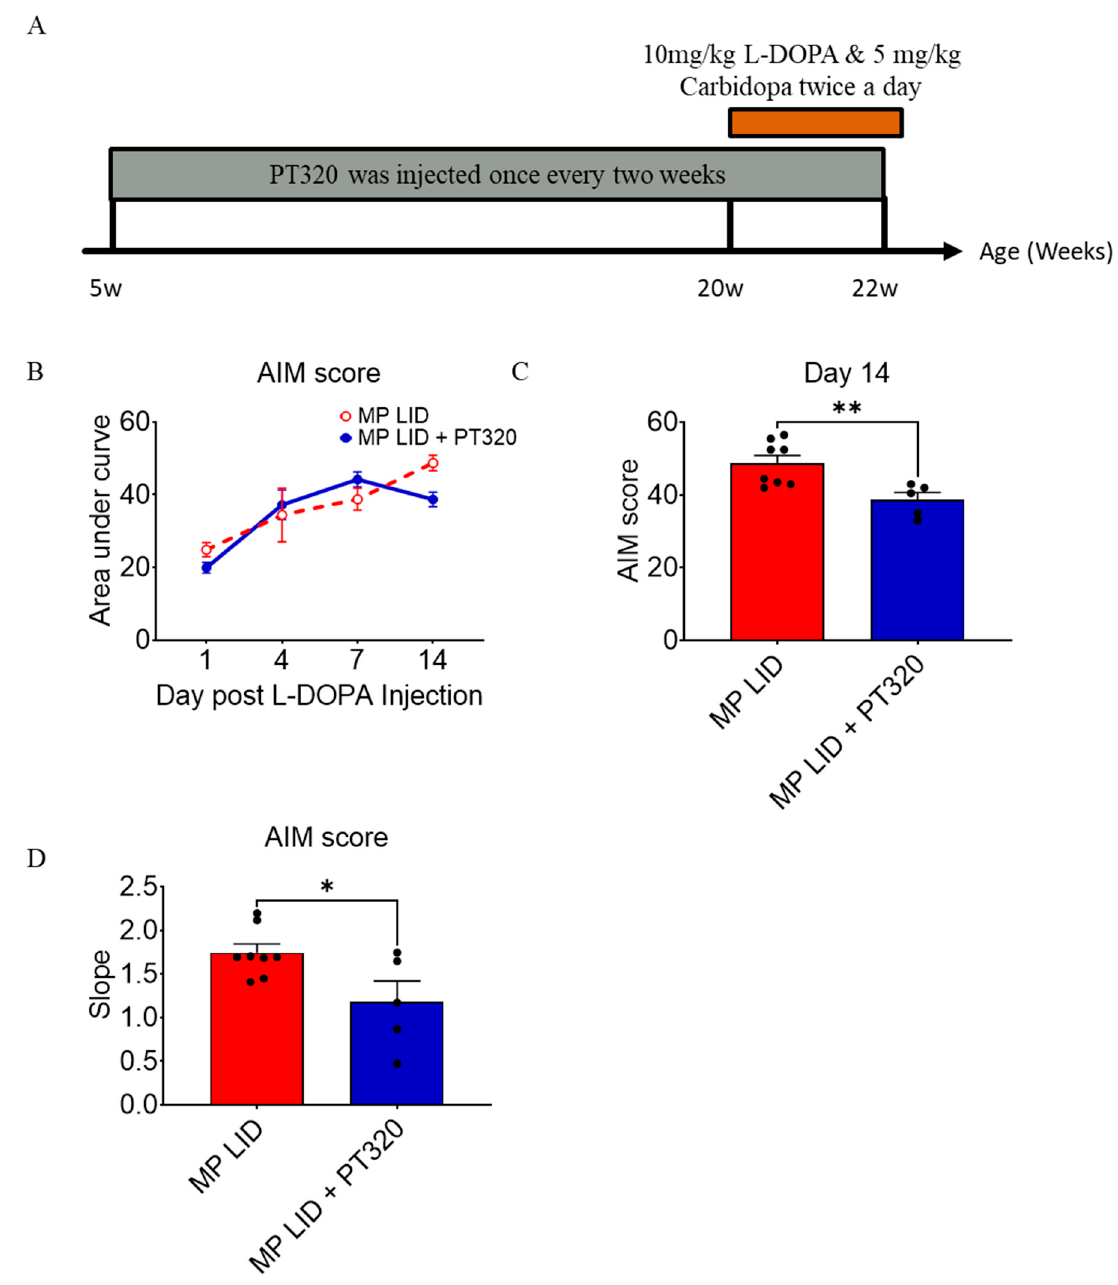
Figure 2. The early administration of PT320 ameliorated the severity of dyskinesia induced by L-DOPA injection after a 2-week induction protocol in 20-week-old MP. ( A ) Early PT320 treatment was started at 5 weeks of age in MP mice while the LID induction protocol was initiated in MP mice at 20 weeks of age. ( B ) The severity of dyskinesia was measured via AIM scores. ( C ) The AIM scores of the PT320 treatment group showed less severe dyskinesia than those of the non-treatment group (MP LID group). ( D ) The slopes of the AIM scores in the PT320 treatment group were less than those of the non-treatment group. Two-way analysis of variance (ANOVA) followed by Bonferroni post hoc test for multiple comparisons * compared with MP LID. * p < 0.05, ** p < 0.01 compared with MP LID. MP LID (N = 8) MP LID + PT 320 (N = 5).